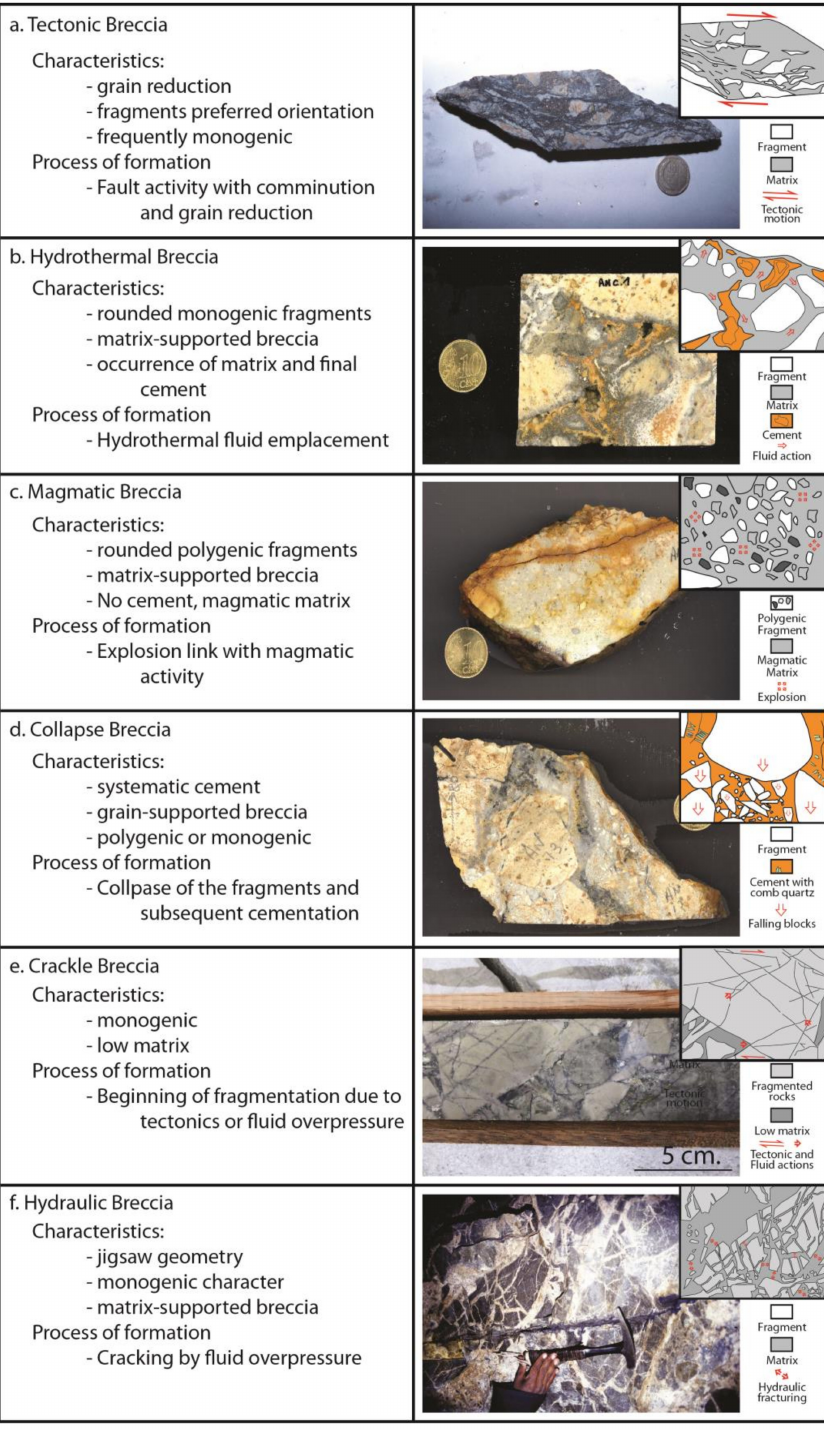
Figure 4. Breccia texture classification frequently used in ore geology. Each case is described in detail in the text. A conceptual sketch is indicated for each photograph in order to correctly interpret the image. The scale of these sketches is the same as the corresponding photograph. In red, some indications about the process responsible for breccia formation are